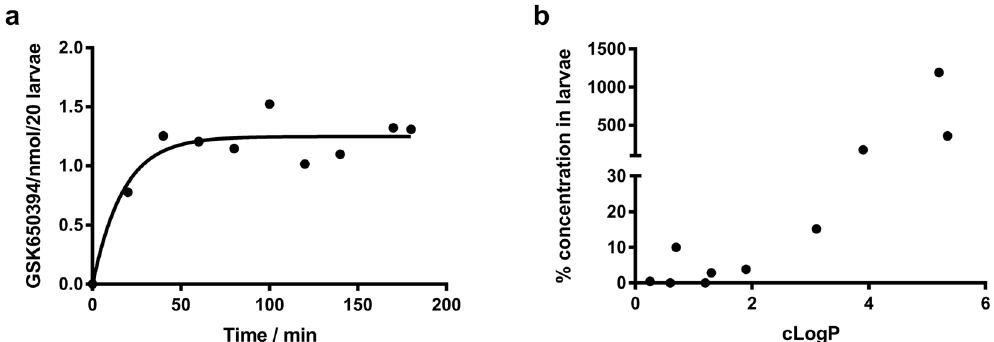
Figure 4. Drug penetration into larvae is not entirely predicted by cLogP. (a ) Amount of GSK650394 in zebrafish larvae was measured at the timepoints shown by mass spectrometry. ( b ) cLogP data from ref. 36 and the corresponding data for GSK650394 are shown plotted against fold enrichment of the compound in larvae compared to the concentration in surrounding liquid. Data are for larvae at 3 dpf incubated for 1